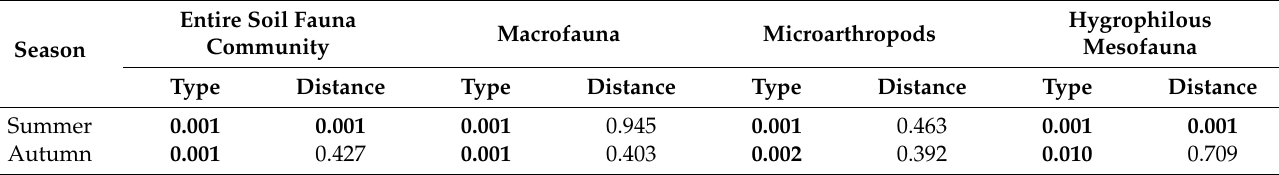
Table 3. p values of PERMANOVA for revetment type and